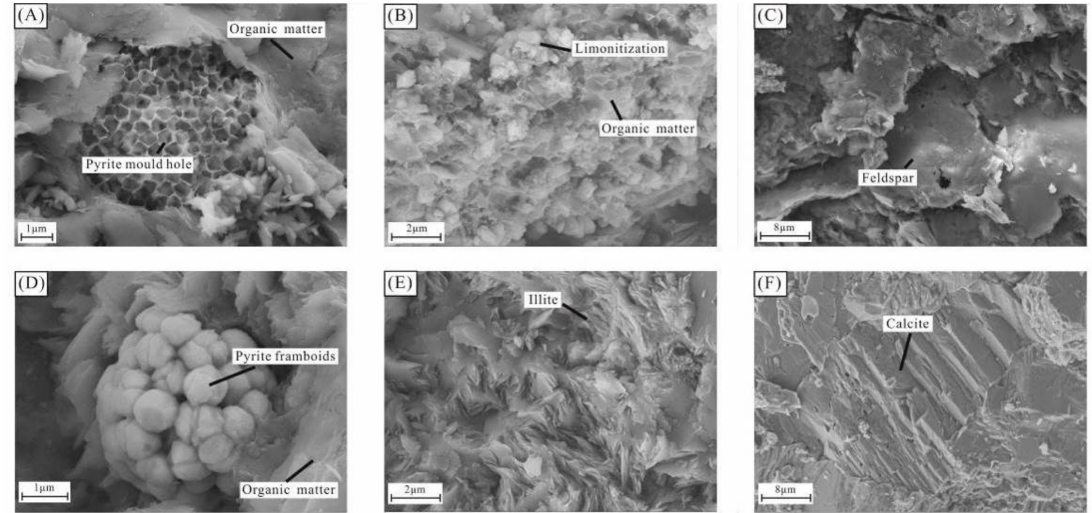
Figure 3. SEM of minerals characteristics. ( A ) PMZ001; ( B ) PMH008; ( C ) PMH024; ( D ) PMD010; ( E ) PML003; and ( F ) PML007. ( A – C ) Niutitang Formation; and ( D – F ) Longmaxi Formation.